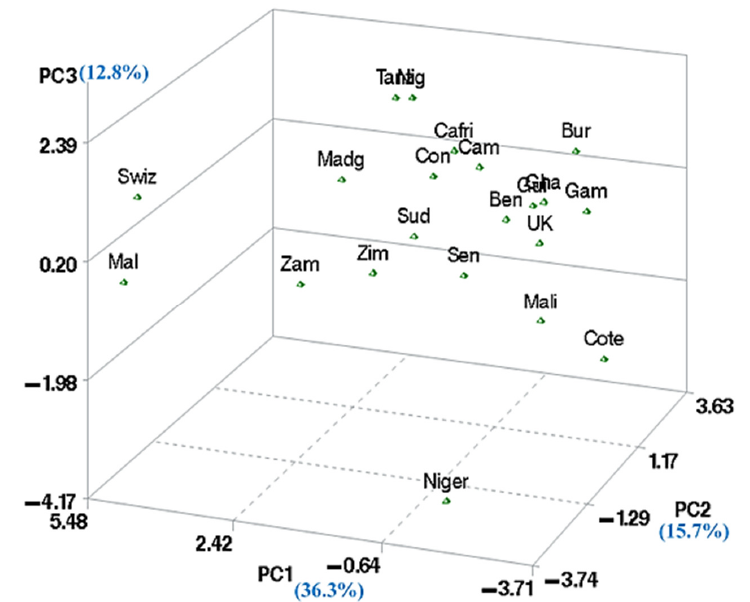
Figure 3. The display of the twenty-one countries for the different accessions they hold in a tri-dimensional figurative display